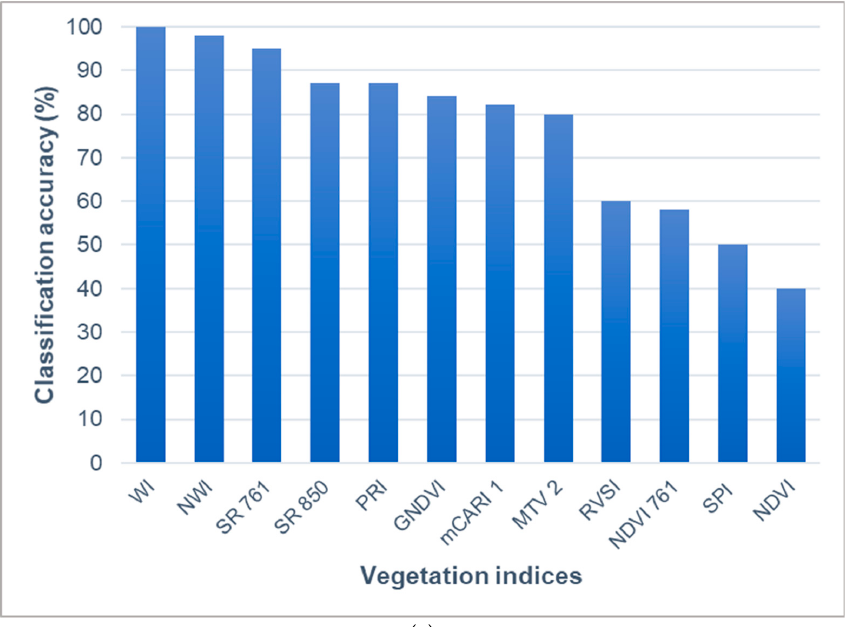
Figure 9. Determination of classification accuracies for indoor and outdoor conditions using vegetation indices and the RBF and KNN methods for the detection of citrus canker. The maximum classification accuracies for indoor and outdoor conditions for healthy vs. different canker disease stages (asymptomatic, early and late stage) are indicated.